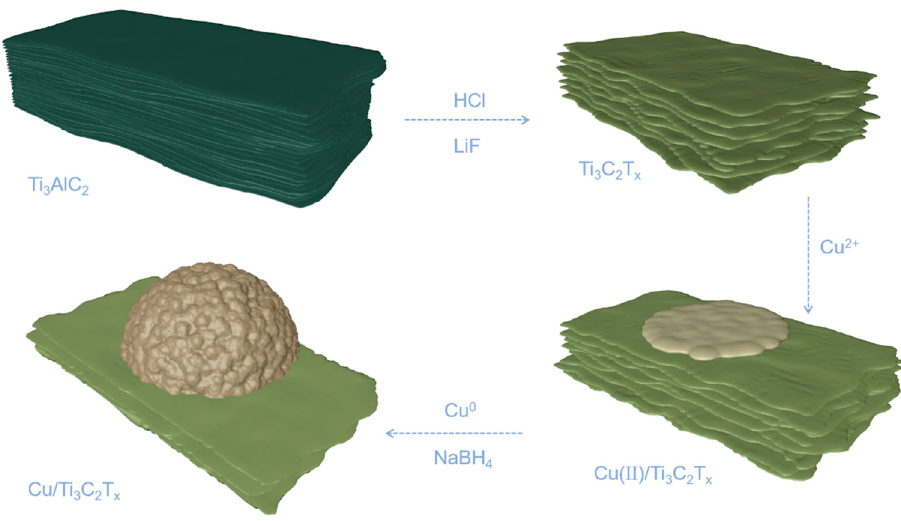
Figure 1. The illustration of the synthetic for Cu/Ti 3 C 2 T